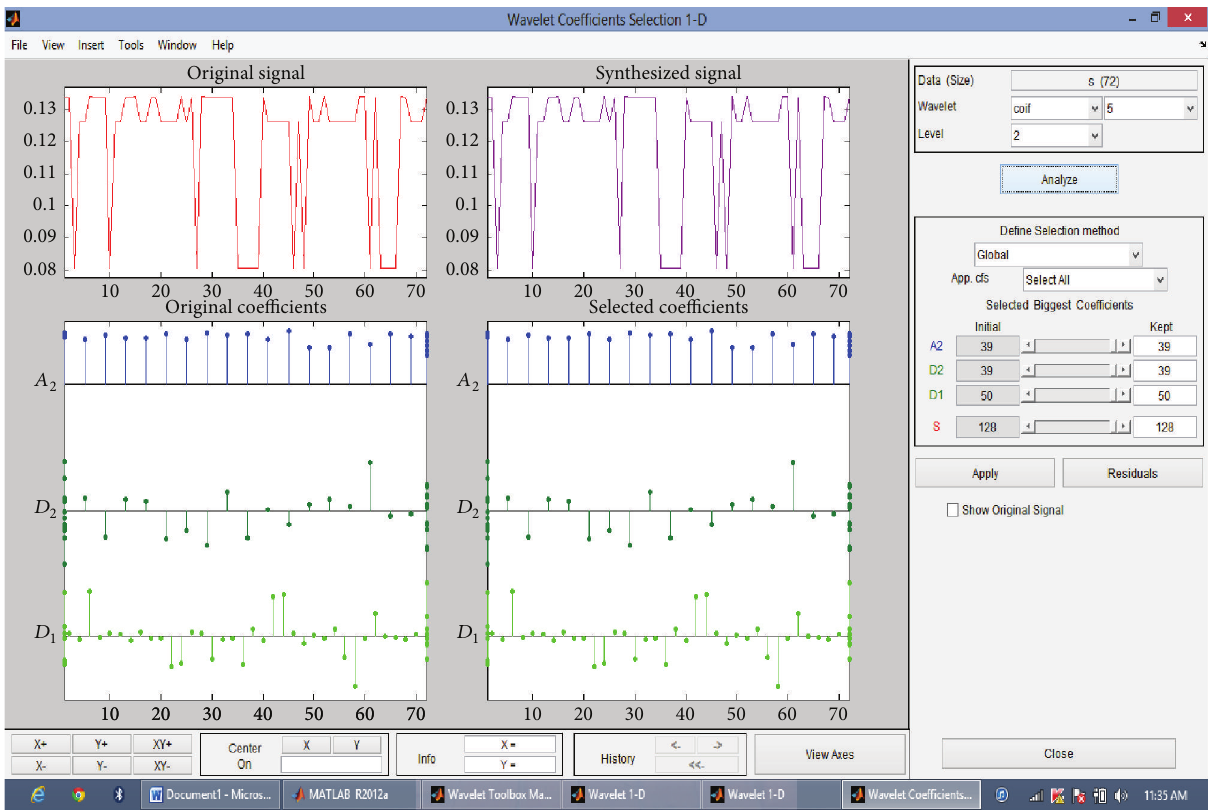
Figure 3: Coiflet 5 (level 2), wavelet coefficients selection using wavelet tool box.